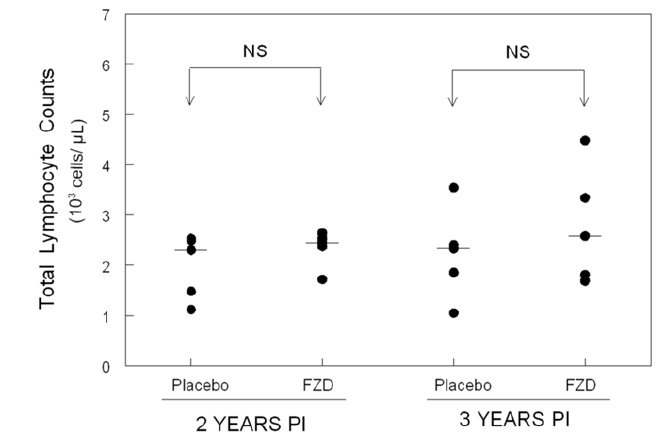
Figure 1. Total lymphocyte counts in placebo- and FZD-treated cats during chronic FIV infection. No statistical differences in total lymphocyte counts were observed between Fozivudine (FZD)-treated cats and placebo-treated cats at two or three years PI. The mean lymphocyte count is displayed as a line for each group evaluated. Five cats were evaluated for each experimental group. ( p < 0.05, NS = not significant).